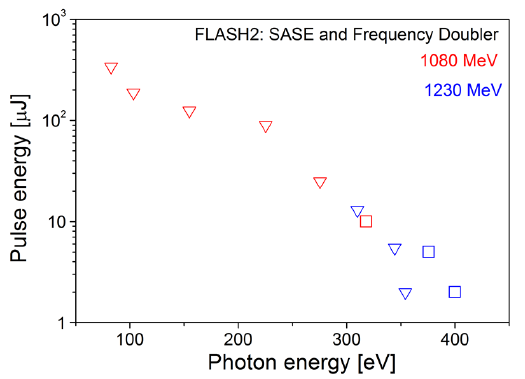
Figure 10. Setting the first part of the undulator to twice the final wavelength (squares), the final wavelength that can be reached with reasonable pulse energy is much shorter and has more stable intensity than with setting all undulators to the same resonant wavelength